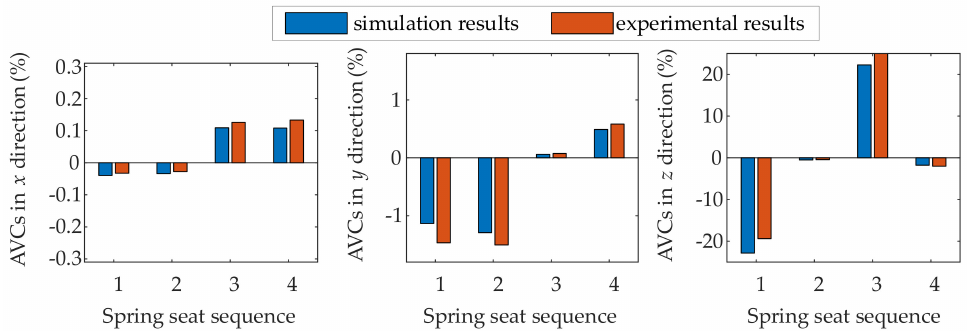
Figure 12. The amplitude variation coe ffi cients (AVCs) of each spring seat in the x , y , and z directions under spring failure kind 3, including the simulation results and experimental results.